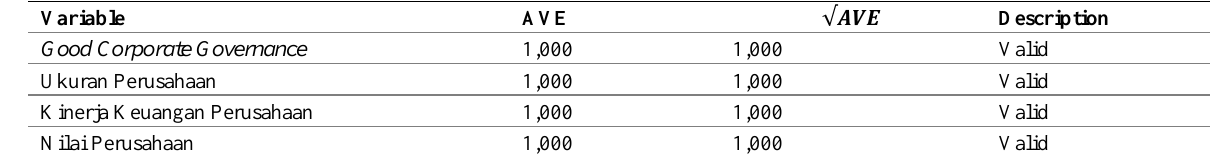
Table 4: Discriminant Validity Test Results